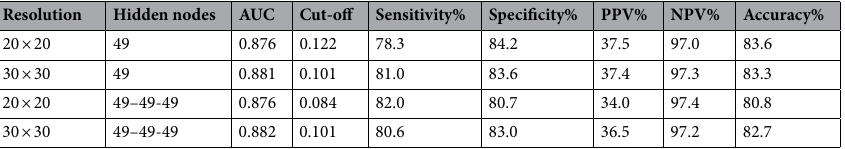
Table 1. Test results regarding the detection of pneumothorax location in chest X-rays using fully-connected small artificial neural networks with a sigmoid activation function for all